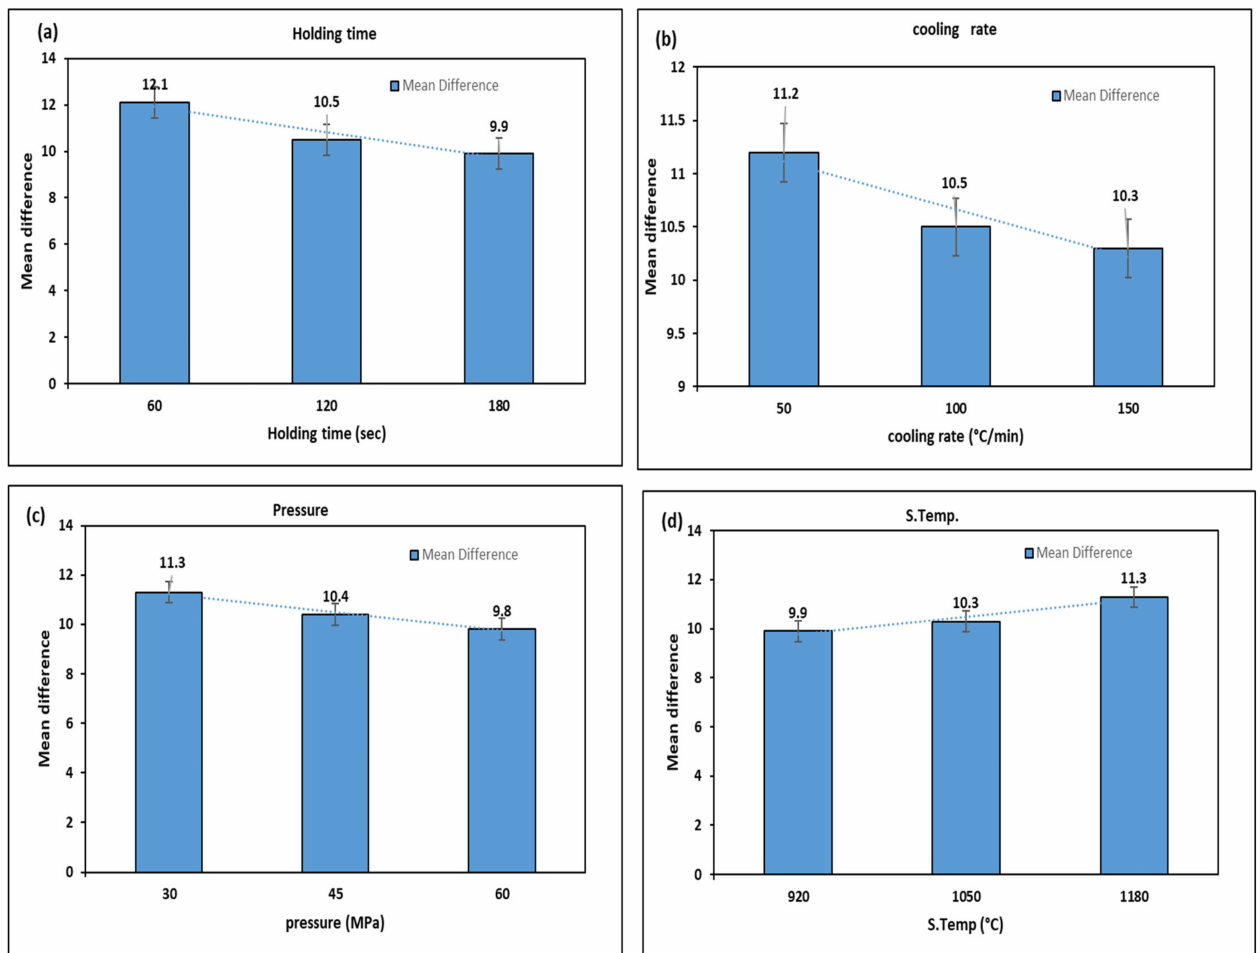
Figure 4. The effect of sintering parameters on mean difference between Mr (cid:107) and Mr ⊥ : ( a ) Holding time; ( b ) Cooling rate; ( c ) Pressure; ( d ) S.